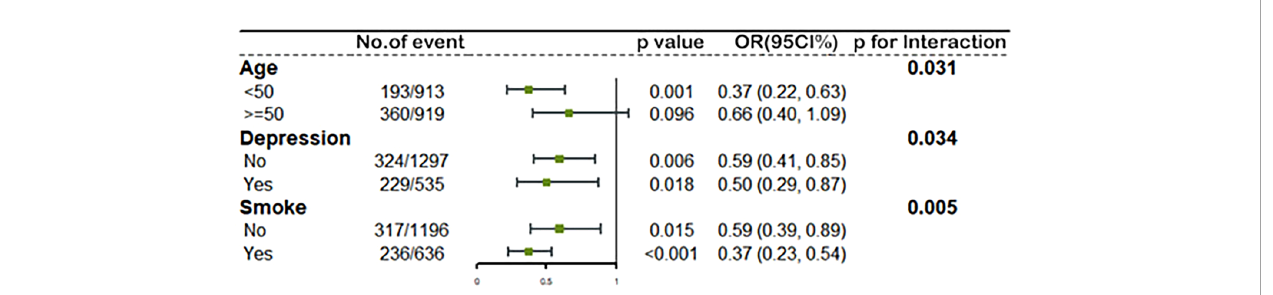
FIGURE 3 The association between ln TT and MetS strati fi ed by age, depression status and smoke by logistic regression. All models adjusted for race, education level, marital status, ratio of family income to poverty, BMI, alcohol use, sleep disorders, total caloric intake per day, and NLR. The green spot and lines represent the odds ratios (OR) and 95% con fi dence interval of OR. Ln TT, ln-transformed total serum testosterone level; MetS, metabolic syndrome; BMI, body mass index; NLR, neutrophil-to-lymphocyte ratio.